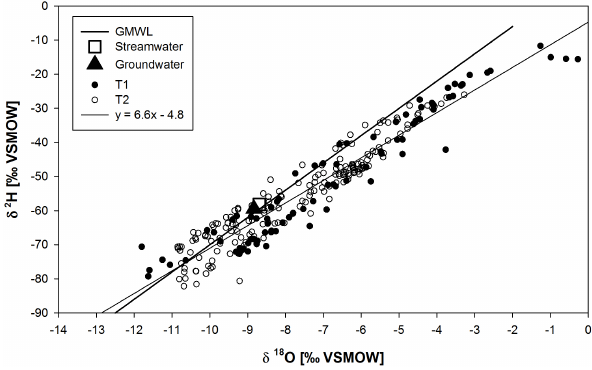
Fig. 3. δ 2 H – δ 18 O plot of the pore water samples of the soil, streamwater and